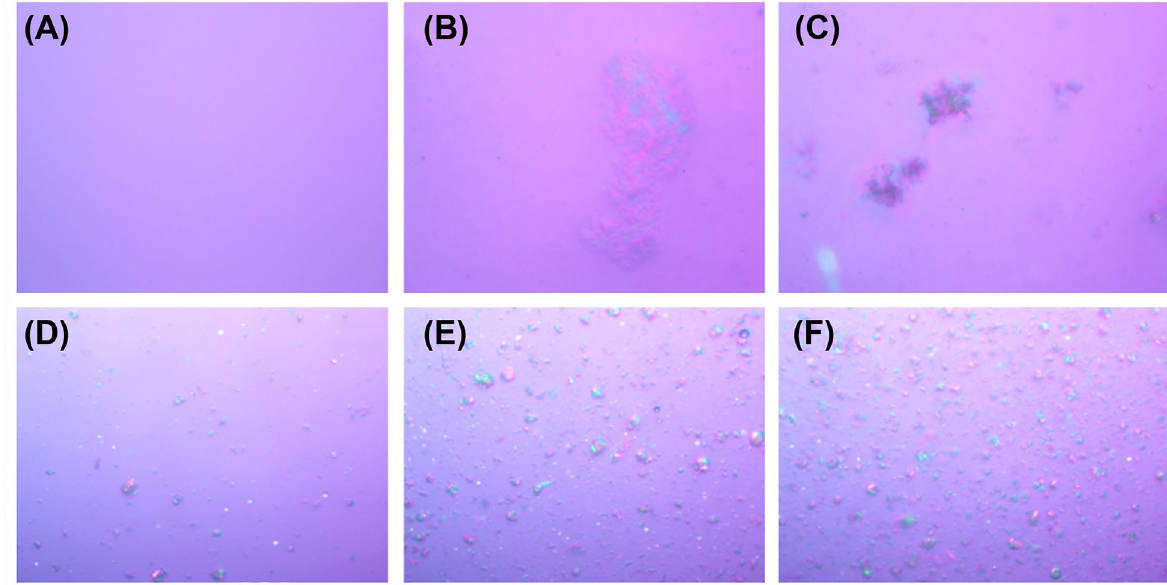
Figure 5. Liquid crystal formation under polarized light optical microscope (magnification 10×) of formulations containing LC with the concentration of 1% w / w ( A ), 2% w / w ( B ), and 3% w / w ( C ), and LCM with the concentration of 1% w / w ( D ), 2% w / w ( E ), and 3% w / w ( F ).